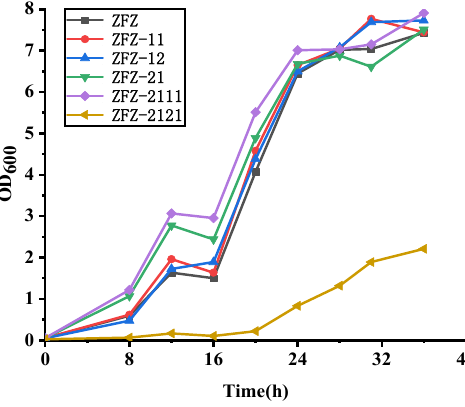
Figure 3. Growth curve of recombinant strains.